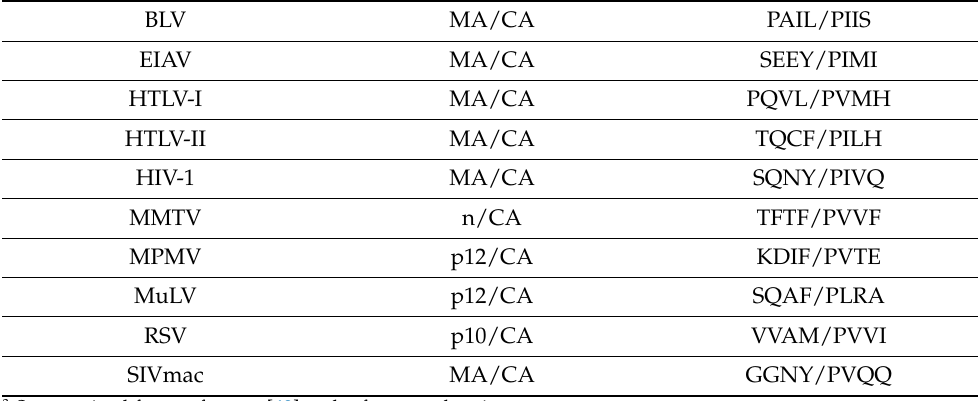
Table 1. Retroviral Protease Cleavage Sites Upstream of CA a